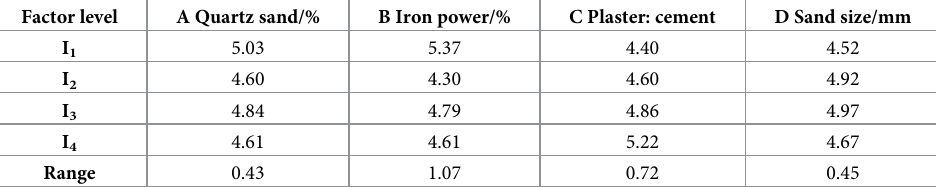
Table 4. Range analysis of σ c /σ t